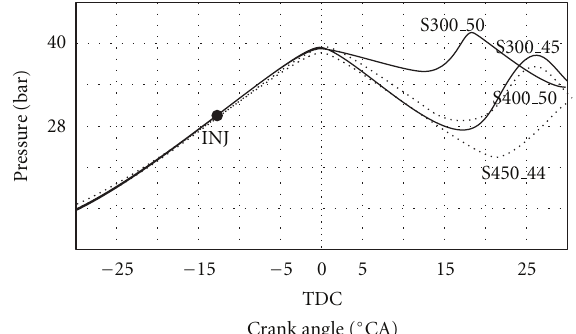
Figure 2: Pressure profiles in the combustion chamber for the base fuels with the lowest CN (S300 45 and S450 44) showed a higher ignition delay time than their respective S300 50 and S400 50